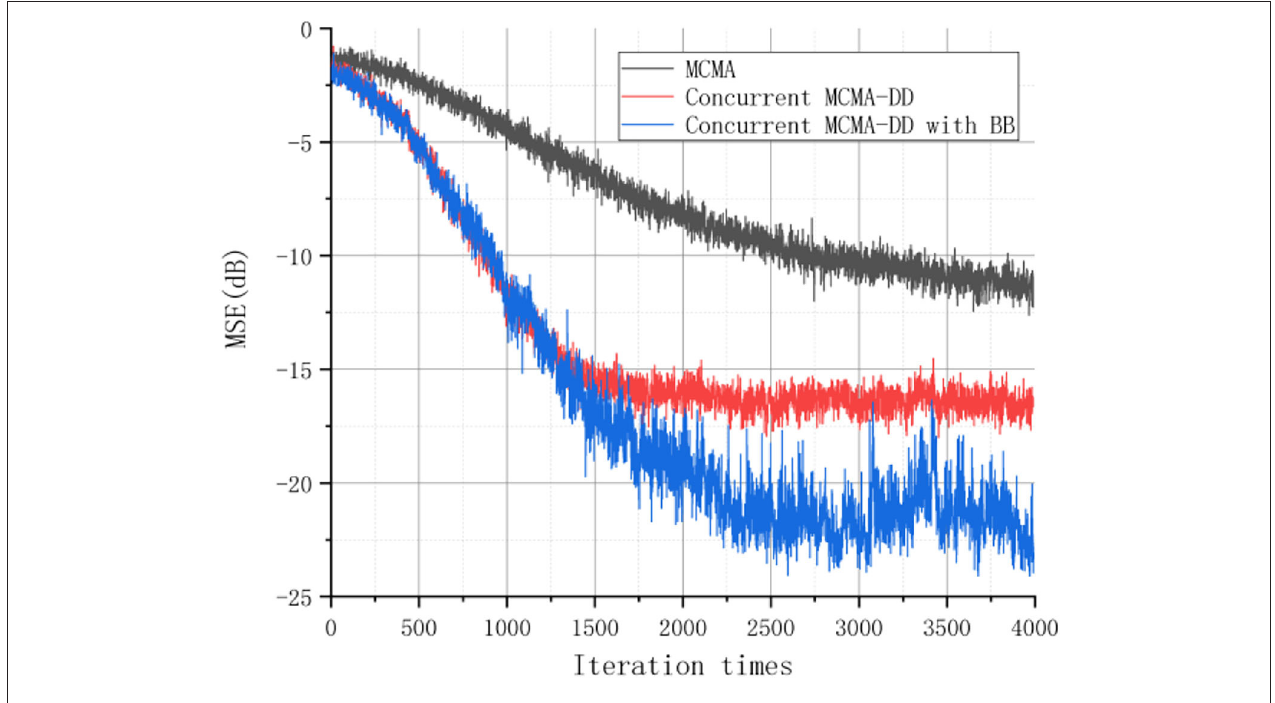
FIGURE 4 | The MSE performance of the three equalizers.